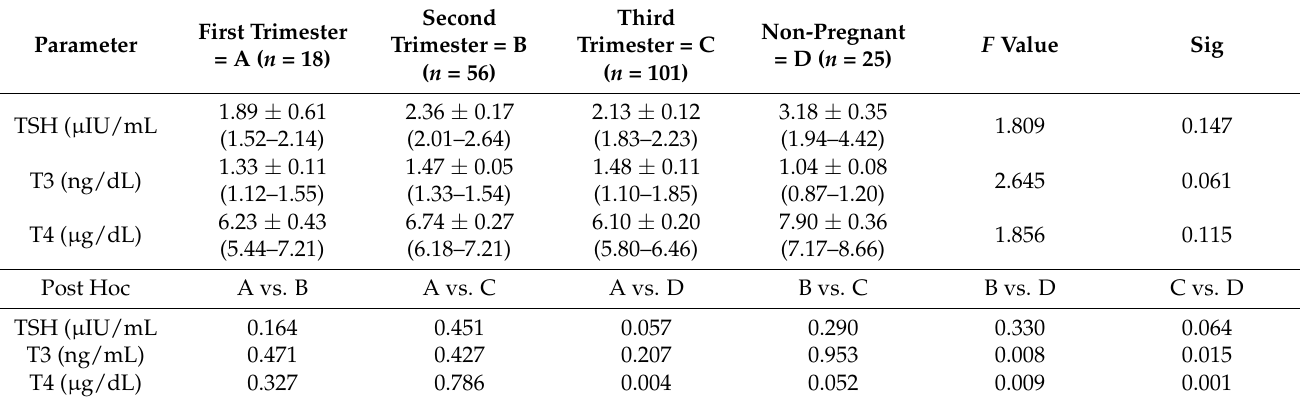
Table 3. Serum thyroid hormone levels at first, second and third trimesters of pregnancy among hypertensive and non-hypertensive pregnant women compared with Non-Pregnant women.